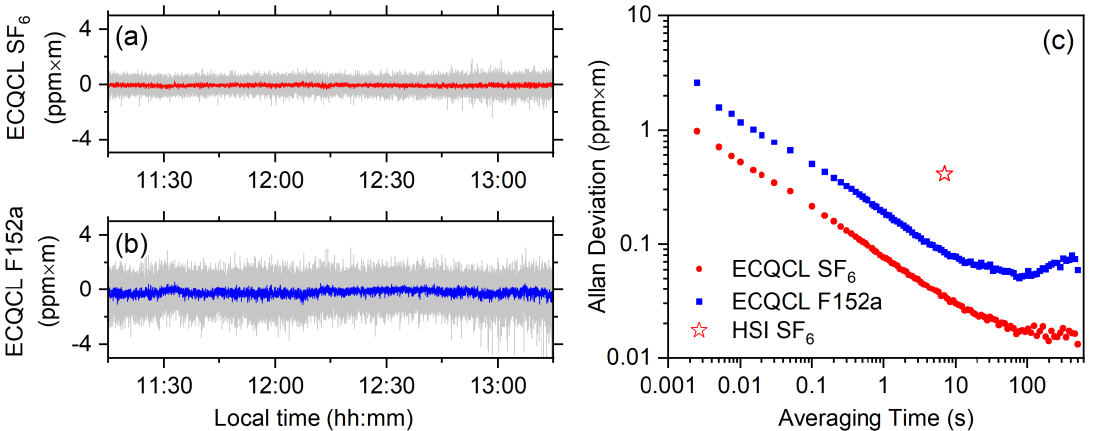
Figure 9. Measured column density for ( a ) SF 6 and ( b ) F152a during a 2-h background period with no plume releases. Light gray traces are for data analyzed at 20 Hz rate, and dark colored traces are data averaged to 1 Hz. ( c ) Allan deviation analysis of background data for column densities of SF 6 (filled circles) and F152a (filled squares). The star indicates the noise-equivalent column density for SF 6 detection using the LWIR-HSI system.